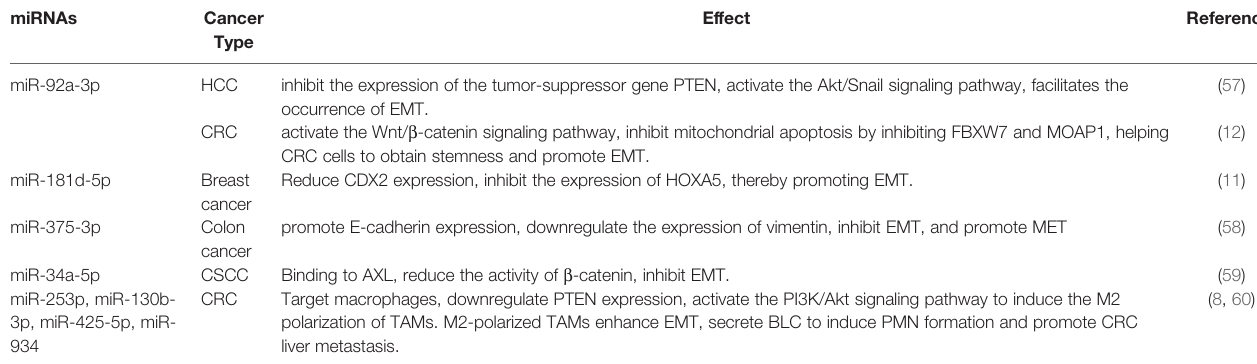
TABLE 2 | The effects of miRNAs carried by exosomes on